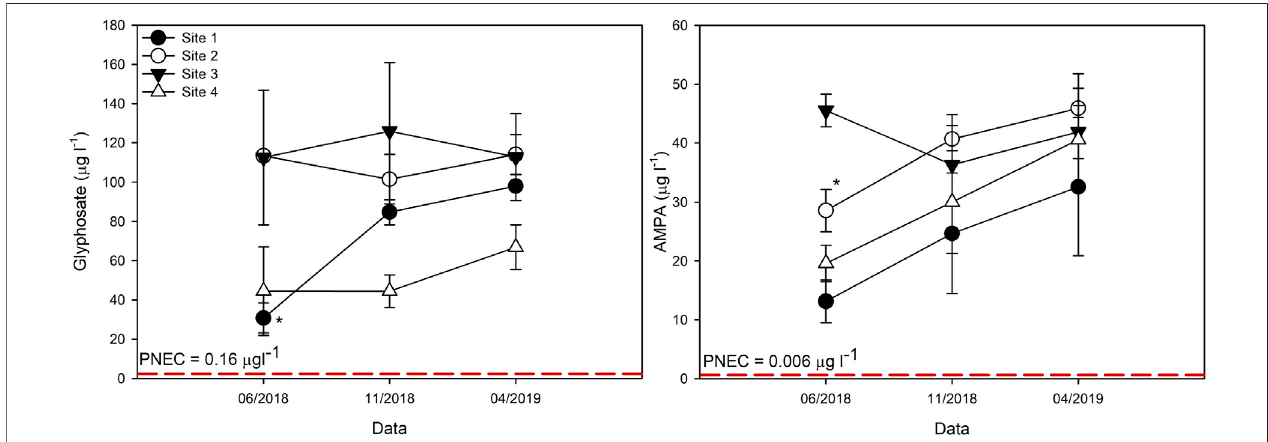
FIGURE3| ConcentrationsofglyphosateandAMPAinsurfacewatersamplesfromriversoftheDoceriverwatershed,MinasGerais,Brazil.Valuesaremeans ± SD of three replicates. Values marked with *, differ signi fi cantly ( p < 0.05) within the same sampling site by the contrast test. Predicted no effect concentration (PNEC) is shown as dotted red line. NOEC (cid:2) concentration with no observed effect.